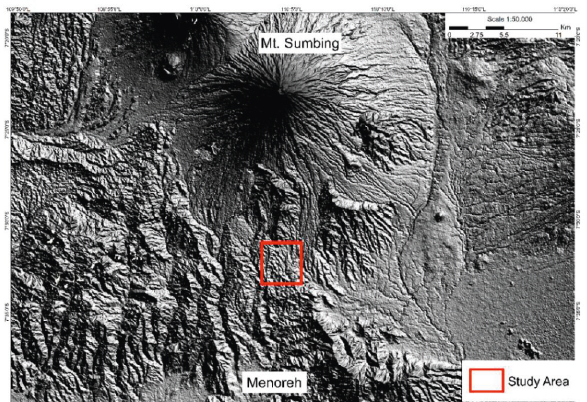
Figure 1: Study area location in the southern slope of Sumbing